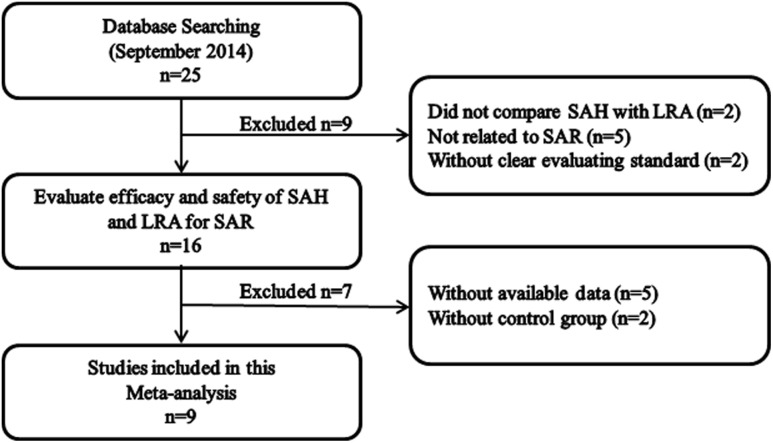
The screening process of studies.